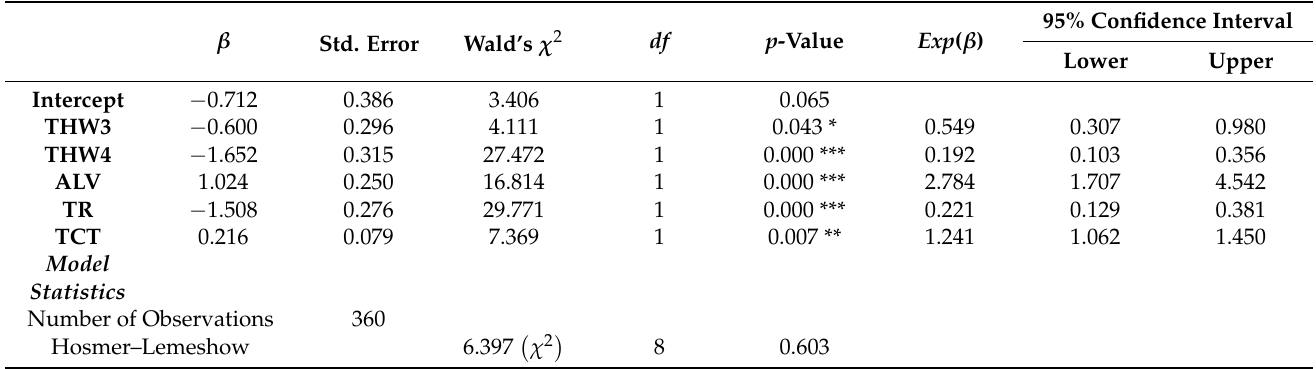
Table 8. Results of the binary logit model for takeover